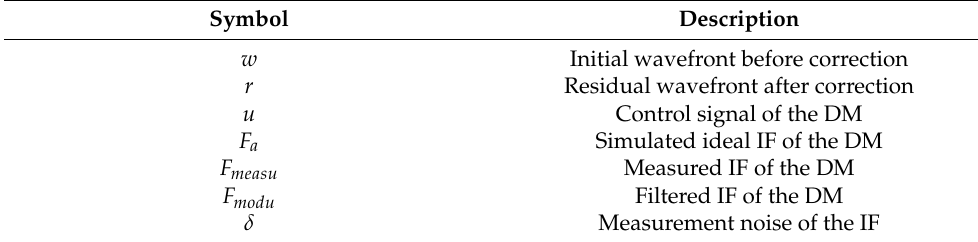
Table 1. Symbols used in the CAM.